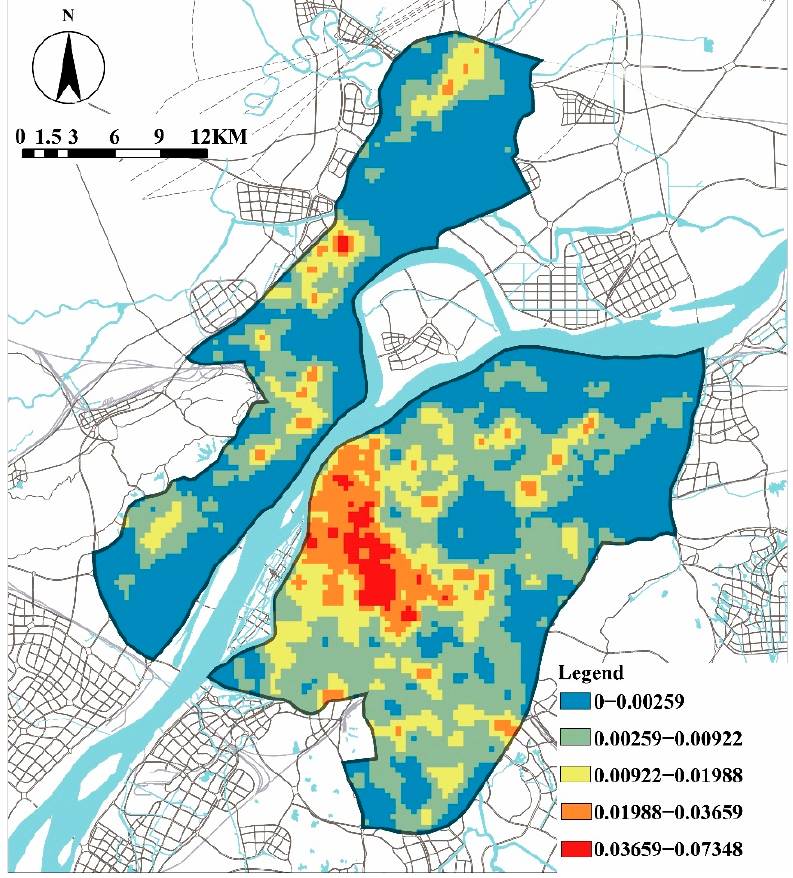
Figure 2. Density of the population in Nanjing.